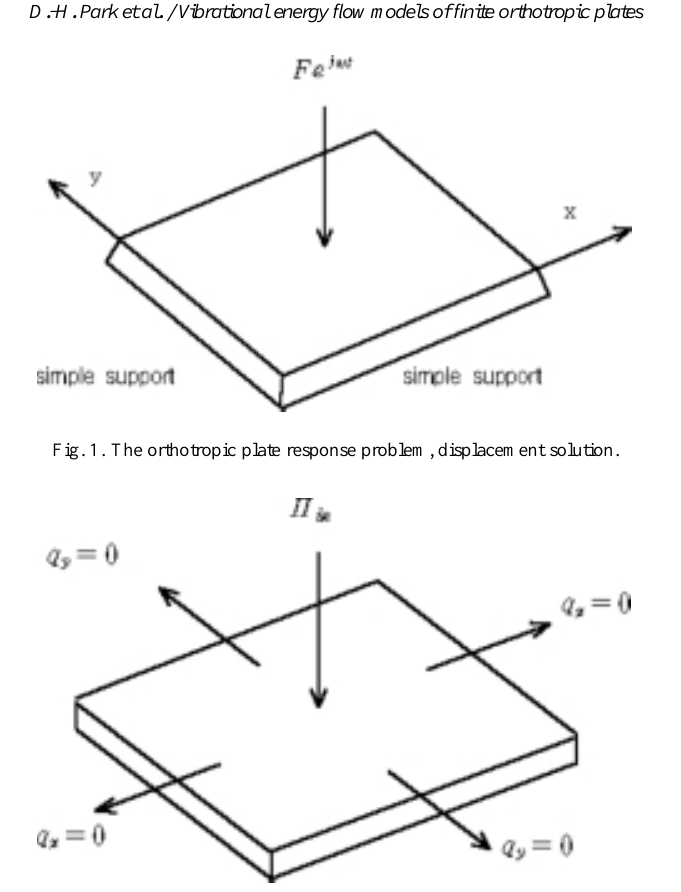
Fig. 2. The orthotropic plate response problem, energy